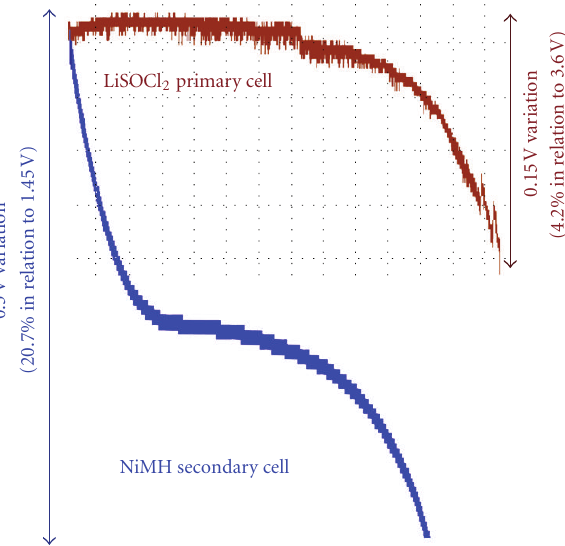
Figure 4: Typical-normalized discharging curves for primary and secondary cells in WSN